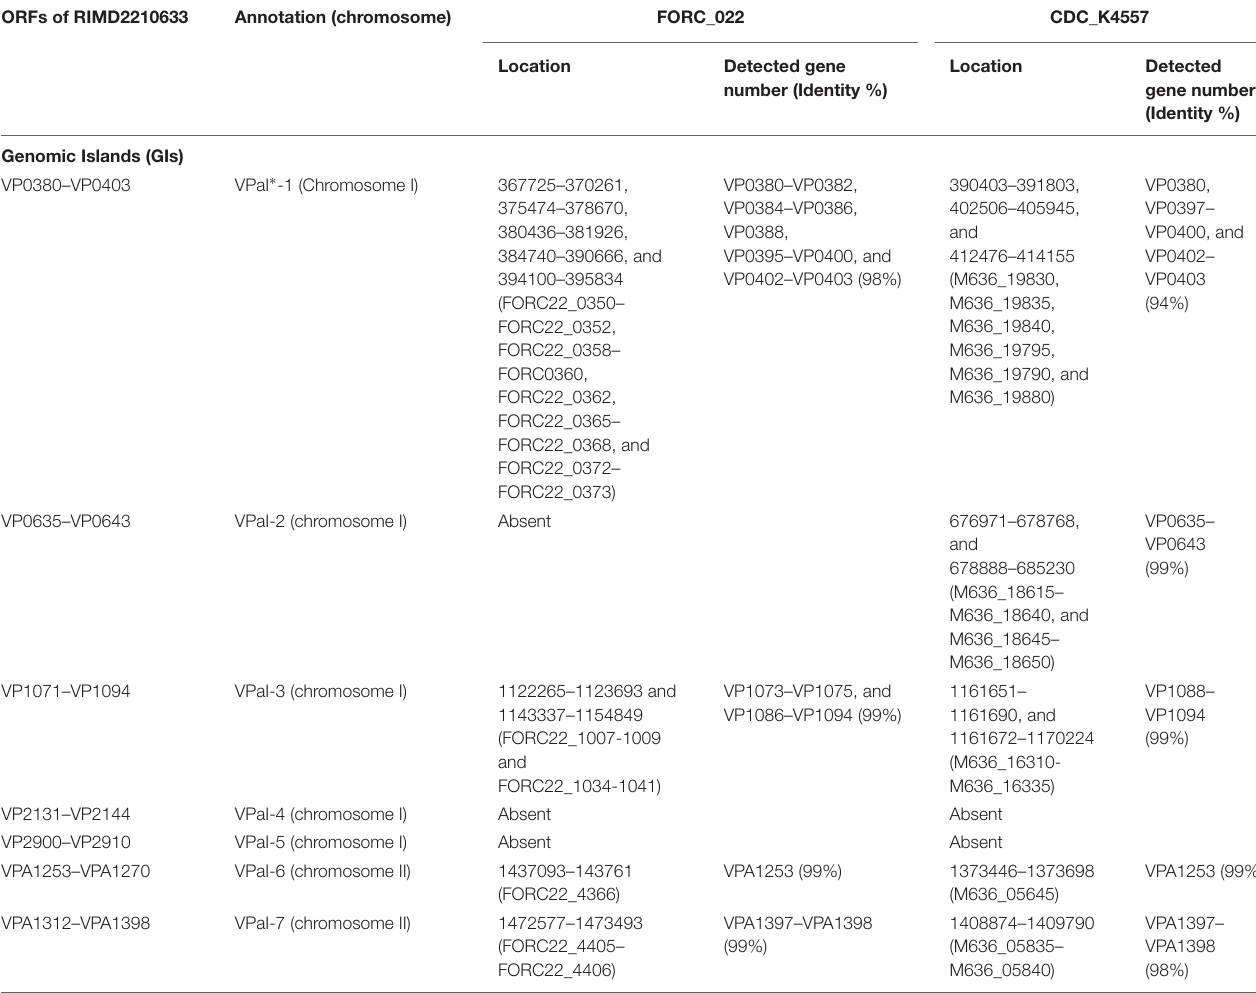
TABLE 2 | Genomic islands (GIs) of V. parahaemolyticus FORC_022 and CDC_K4557, predicted by comparing the GIs in V. parahaemolyticus RIMD2210633. ORFs of